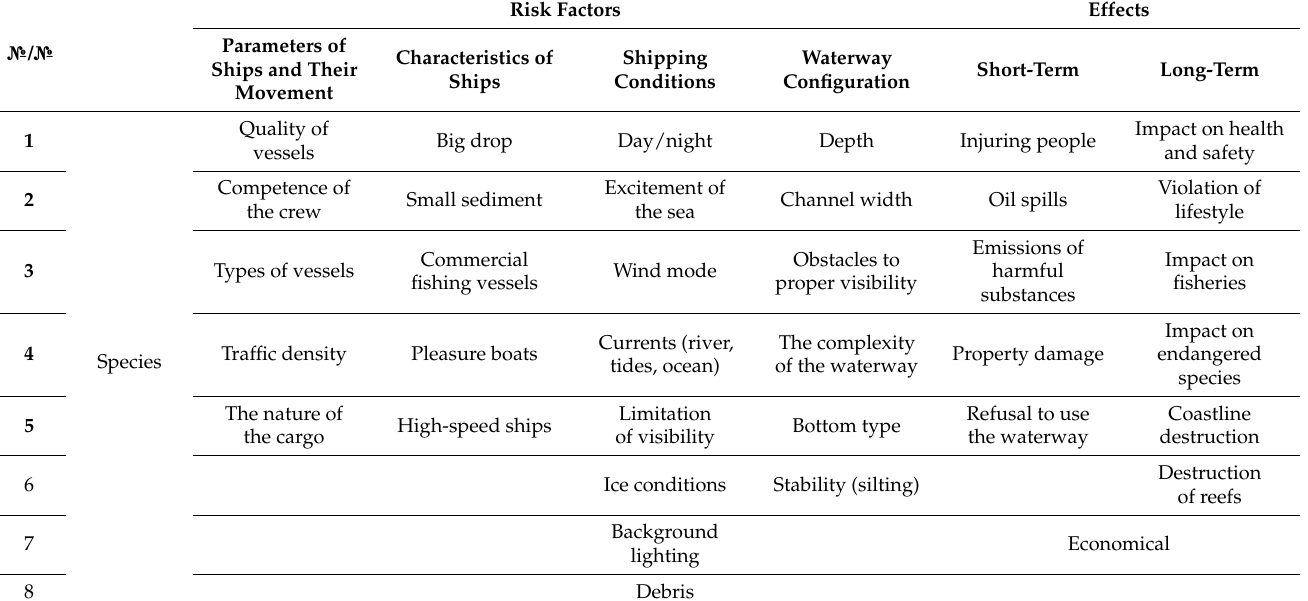
Table 1. Classification of technical and technological risk factors of maritime shipping and their direct